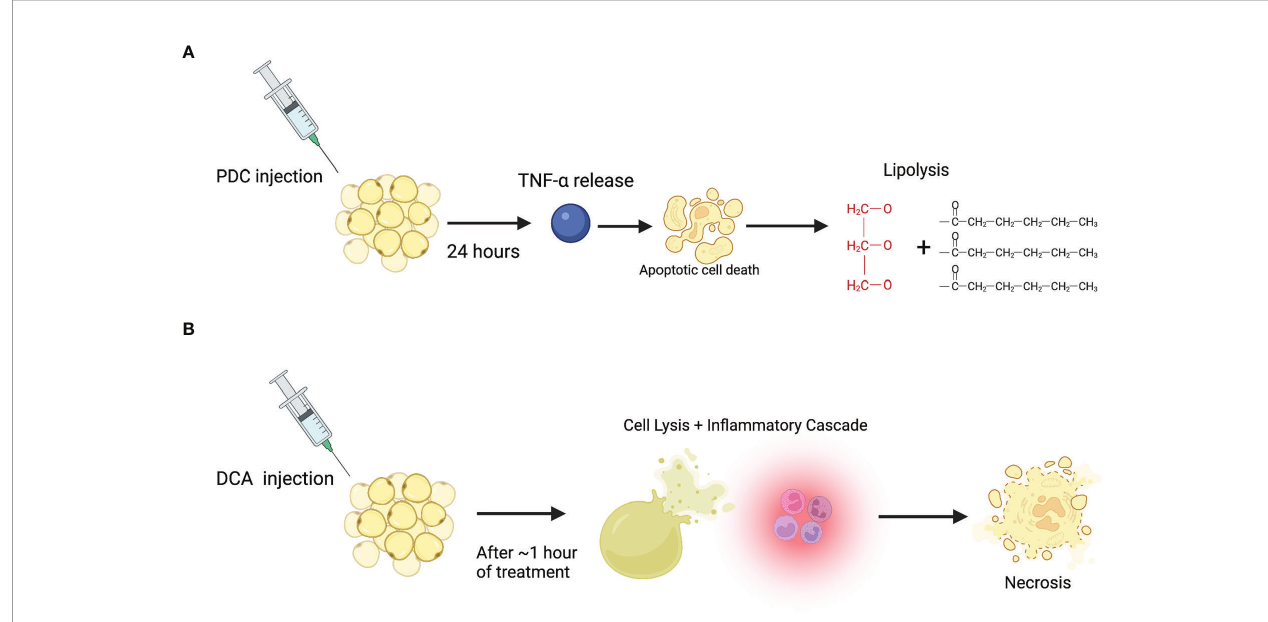
FIGURE 1 | Proposed mechanism of action for PDC and DCA on adipocytes. (A) PDC injection induces TNF- a release which leads to apoptosis and subsequent enzymatic lipolysis after at least 24 hours post-injection. (B) DCA injection induces immediate cell lysis (through a detergent-like effect), accompanying in fl ammation, and subsequent